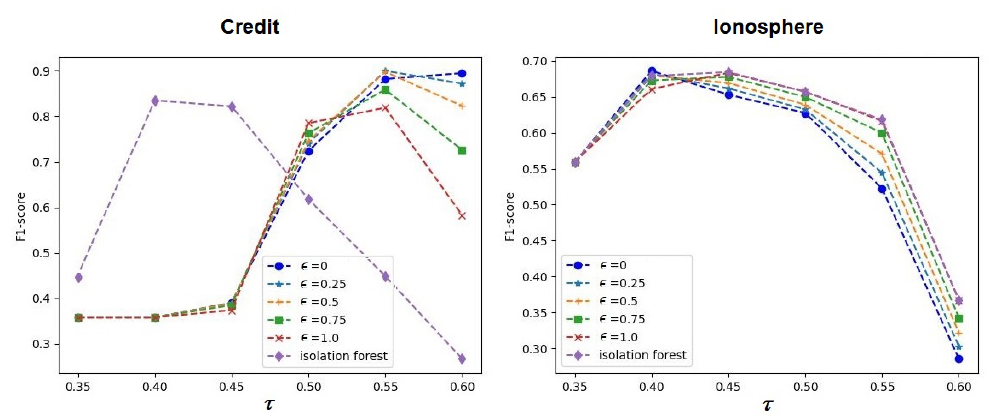
Figure 11. Comparison of iForest and ABIForest with different thresholds τ and with different contamination parameters (cid:101) for the Credit (the left panel) and Ionosphere (the right panel)